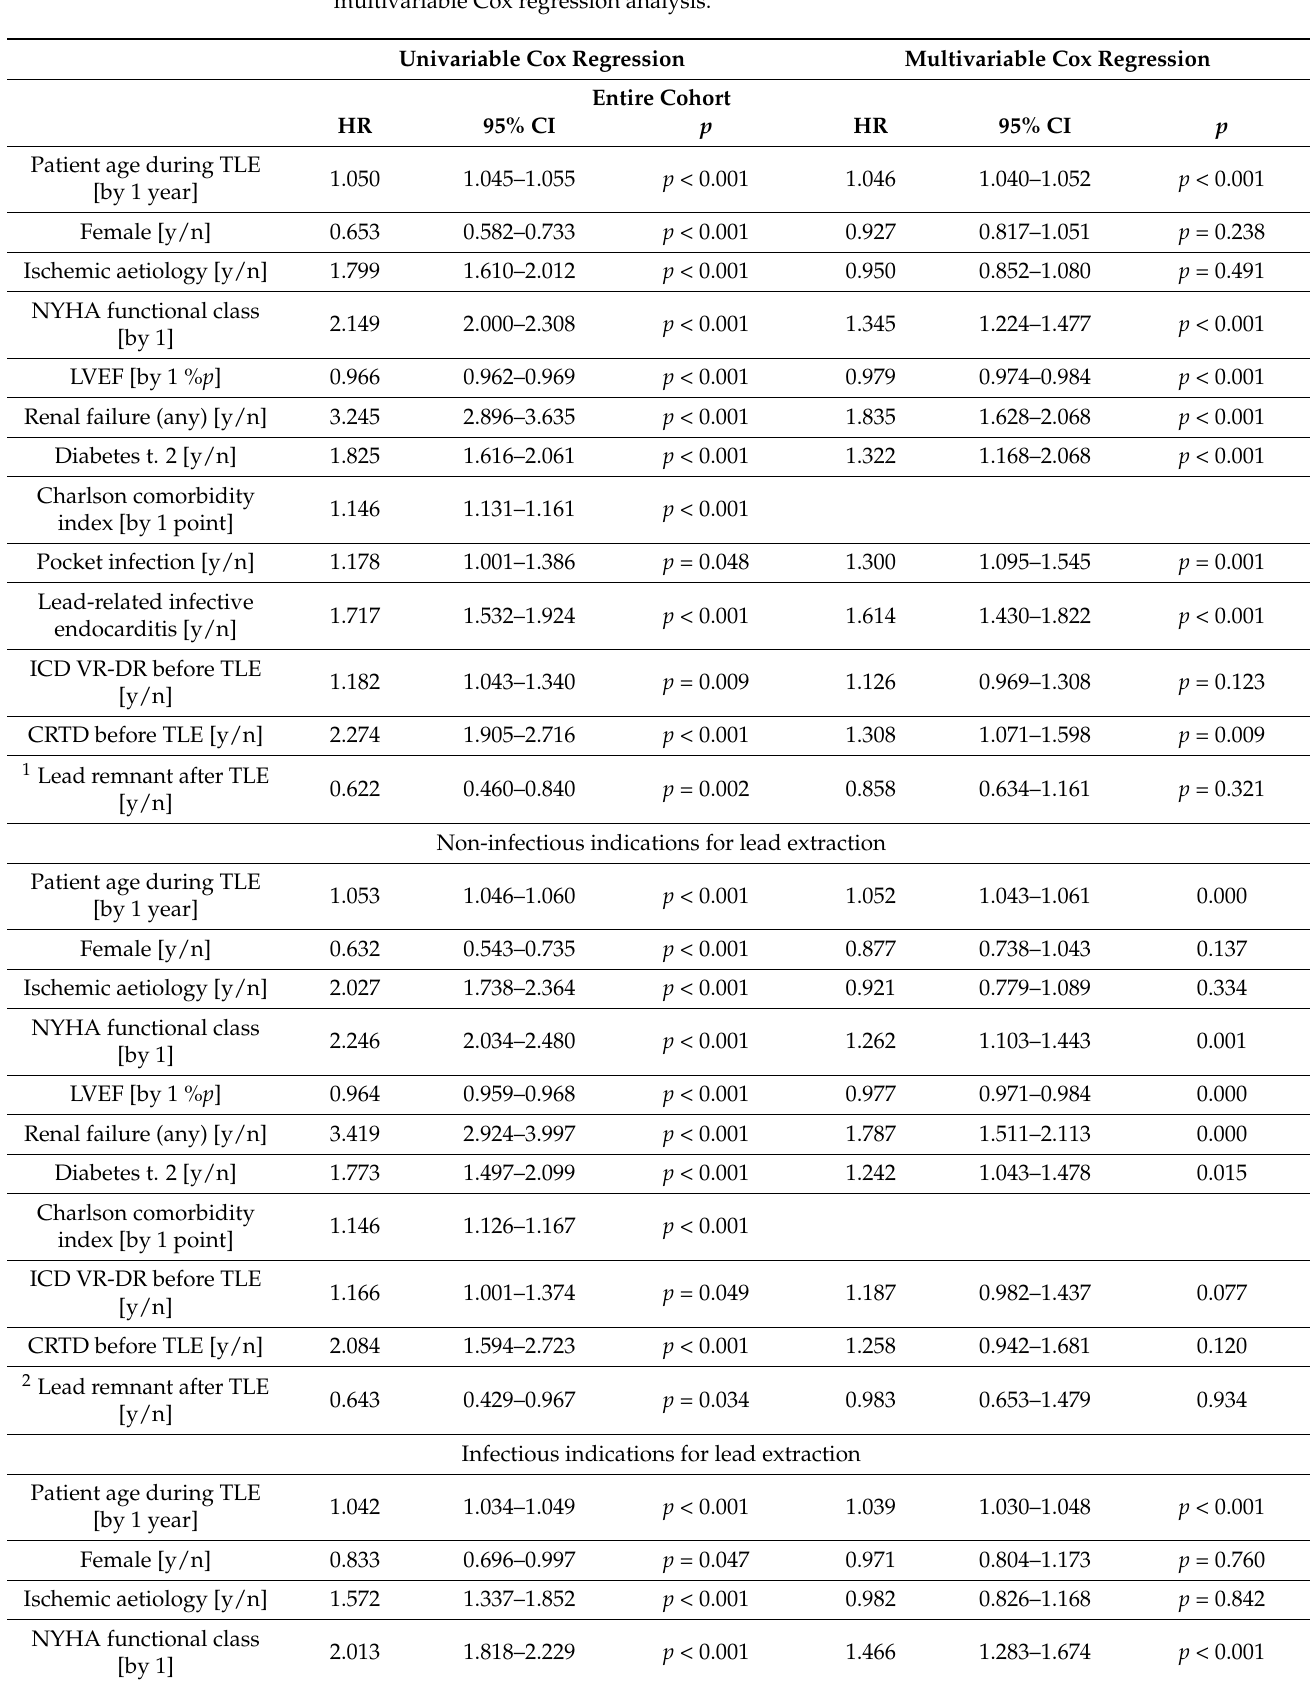
Table 5. Prognostic factors for survival after TLE in the entire cohort of patients in univariable and multivariable Cox regression